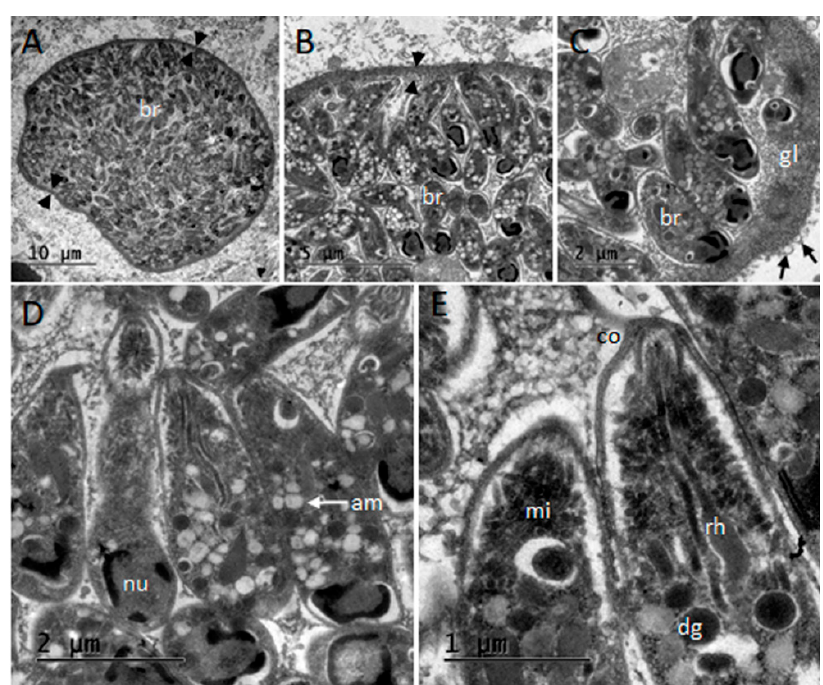
Figure 3. Transmission electron microscopy micrographs of the Toxoplasma gondii tissue cyst studied from central nervous system of striped dolphin ( Stenella coeruleoalba ) SD2 in Liguria, Italy. ( A ) Section of the thin-walled tissue cyst; note the cyst wall (arrowheads) and densely packaged bradyzoites (br). ( B , C ) Details of the simple and thin cyst wall (arrowheads) and granular layer (gl) presenting vesicles (arrows). ( D , E ) Ultrastructural details of bradyzoites, note: nucleus (nu), micronemes (mi), dense granules (dg), amylopectin granules (am), conoid (co), and rhoptries (rh).